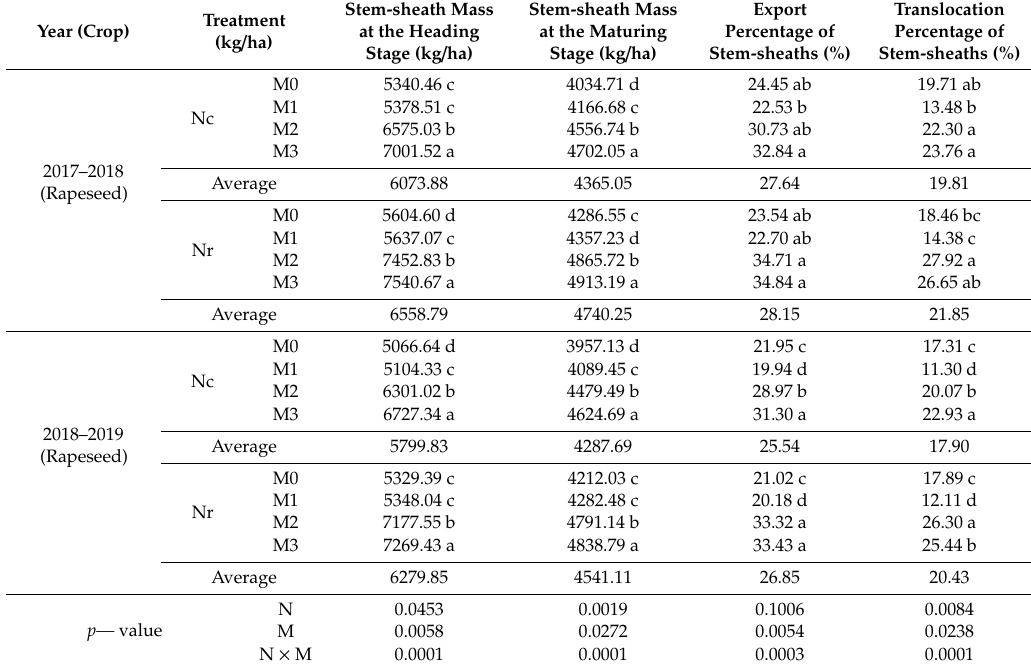
Table 1. E ff ect of N Rate in Rapeseed Season and N Management in Rice Season on the Accumulation and Transport of Hybrid